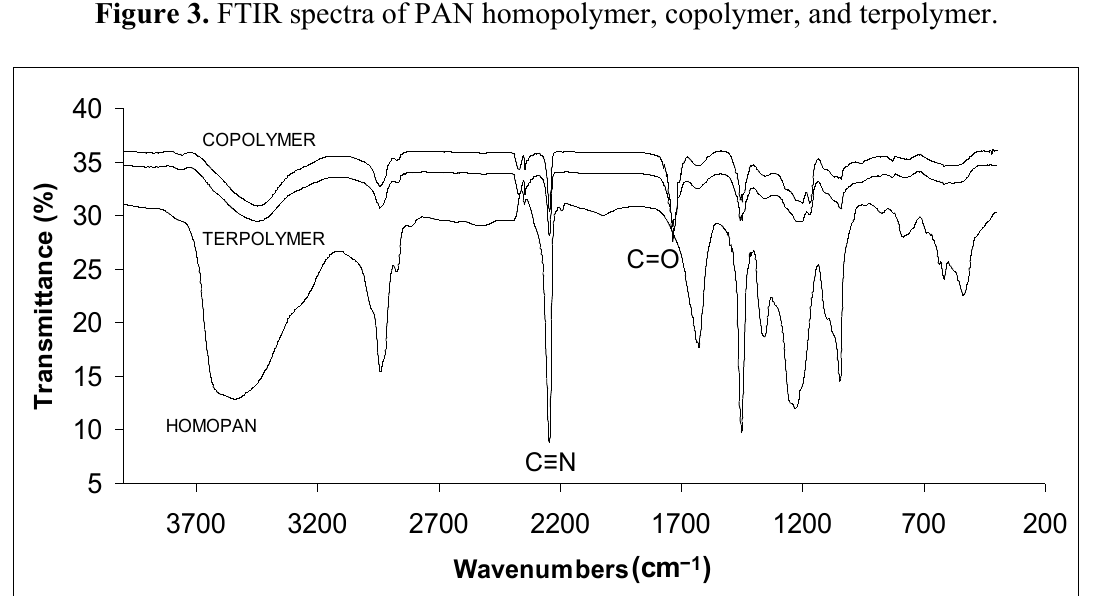
Figure 3. FTIR spectra of PAN homopolymer, copolymer, and